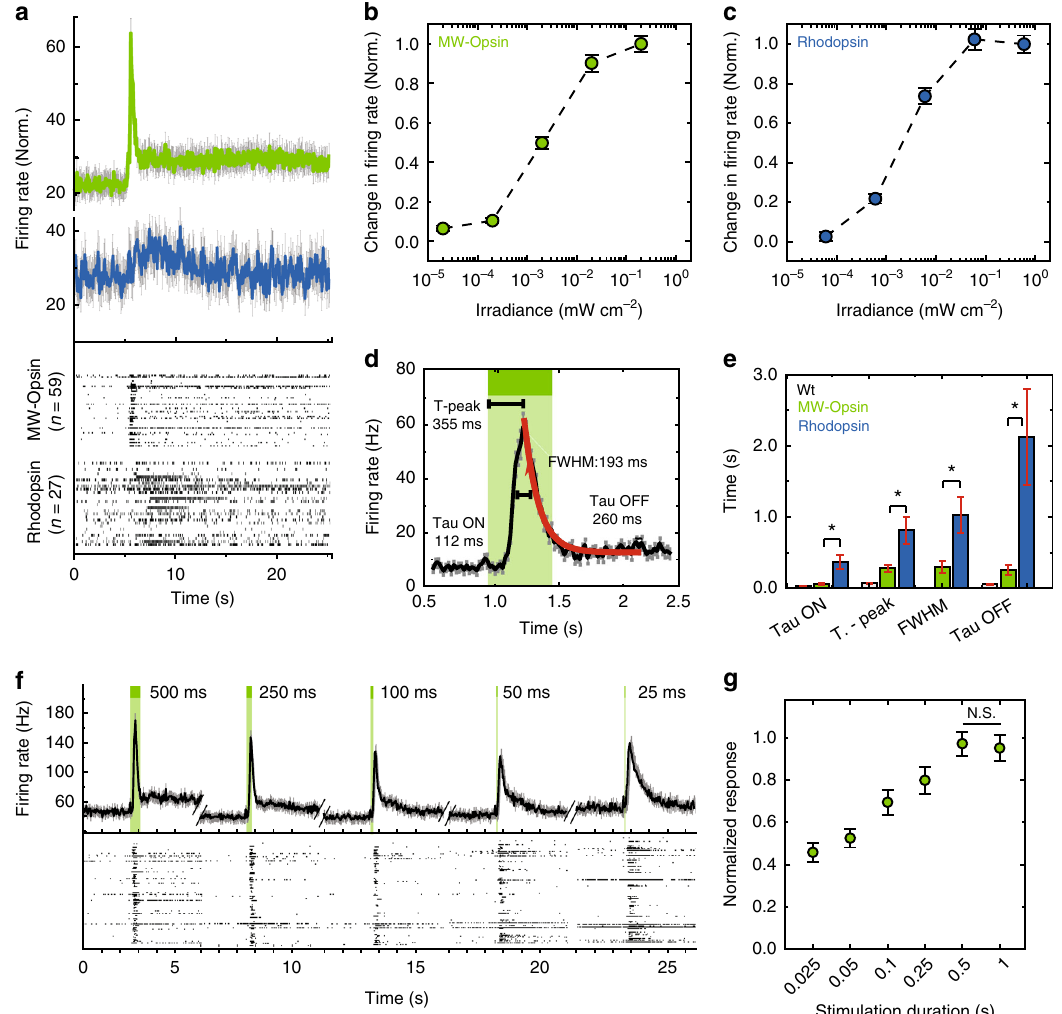
Fig. 2 Light response in isolated rd1 mouse retina with MW-Opsin in RGCs. a (Top) Average response to light fl ash of RGC population expressing MW- opsin (green) or rhodopsin (blue) in rd1 mouse retina. (Bottom) Raster plot of average response of rd1 mouse retina RGCs to 5 fl ashes of 100 ms duration light at 535 nm for MW-opsin ( n = 59 cells) and 510 nm for rhodopsin ( n = 27 cells) expressing in RGCs. b , c Light sensitivity for MW-opsin ( N = 6 retinas) and rhodopsin ( N = 4 retinas) in RGCs of rd1 mouse retina. Peak fi ring rate normalized to maximum at highest intensity. d , e Time-course of light response. Population average traces with time from light onset to max excitation (time to peak: 355 + 21 ms), exponential fi ts for excitatory phase (Tau ON: 112 + 25 ms) and decay (Tau OFF: 260 + 31 ms) and full width at half max (FWHM: 183 + 85 ms) ( e ) for MW-opsin ( d ; e , green; N = 5 retinas, n c = 104 channels), rhodopsin ( e , blue; N = 7 retinas, n c = 134 channels) and wt ( e , white; N = 3 retina, n c = 97 channels). f , g Dependence of MW-opsin light response on fl ash duration. f Representative retina light response ( n = 117 cells): population average fi ring rate (top) and raster plot of unit responses (bottom). g Normalized peak responses for different stimulation durations (2 × 10 0 mW cm − 2 , N = 2 retinas, n c = 63 channels). Light intensity 2 × 10 − 1 units. Cells are sorted units. Values are mean + SEM. Statistical signi fi cance assessed using Mann – Whitney U test (* p ≤